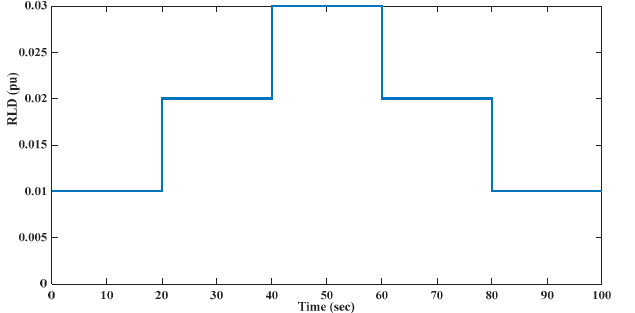
Figure 13. Randomized load pattern (RLP).